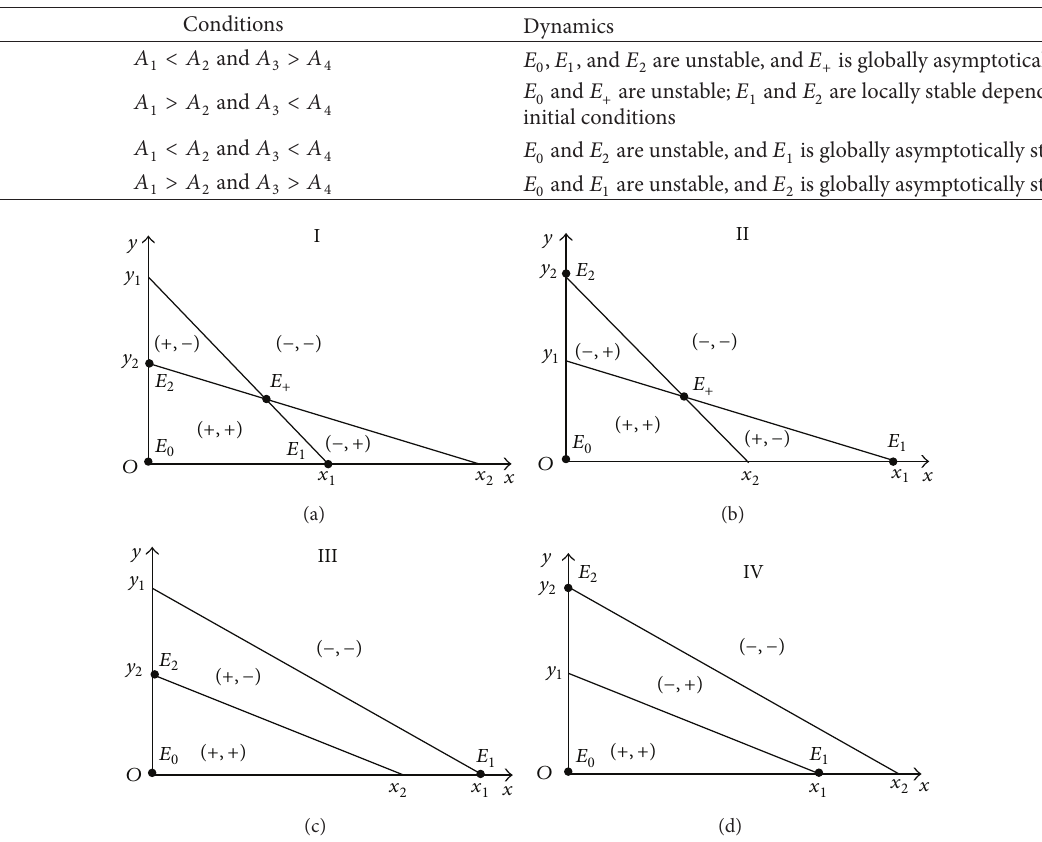
Table 1: Dynamical behaviors of system (1).